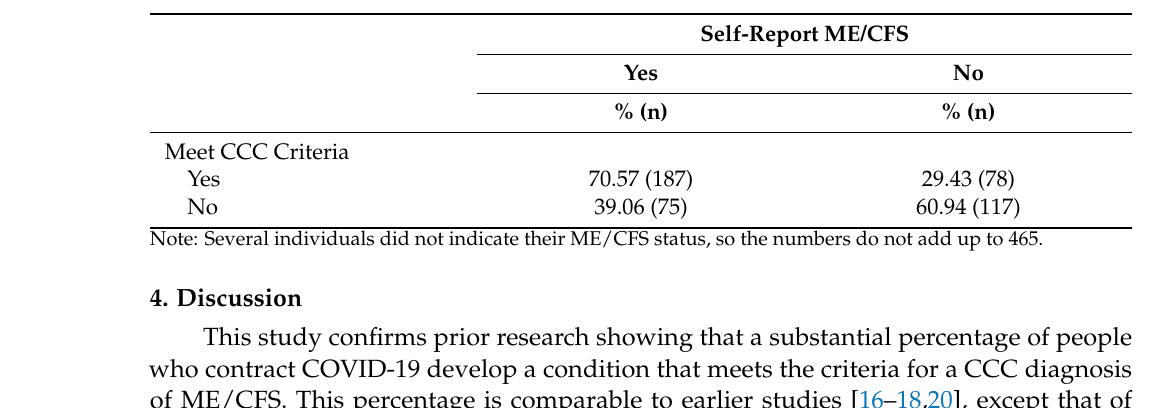
Table 5. Discrepancies between self-reports and ME/CFS